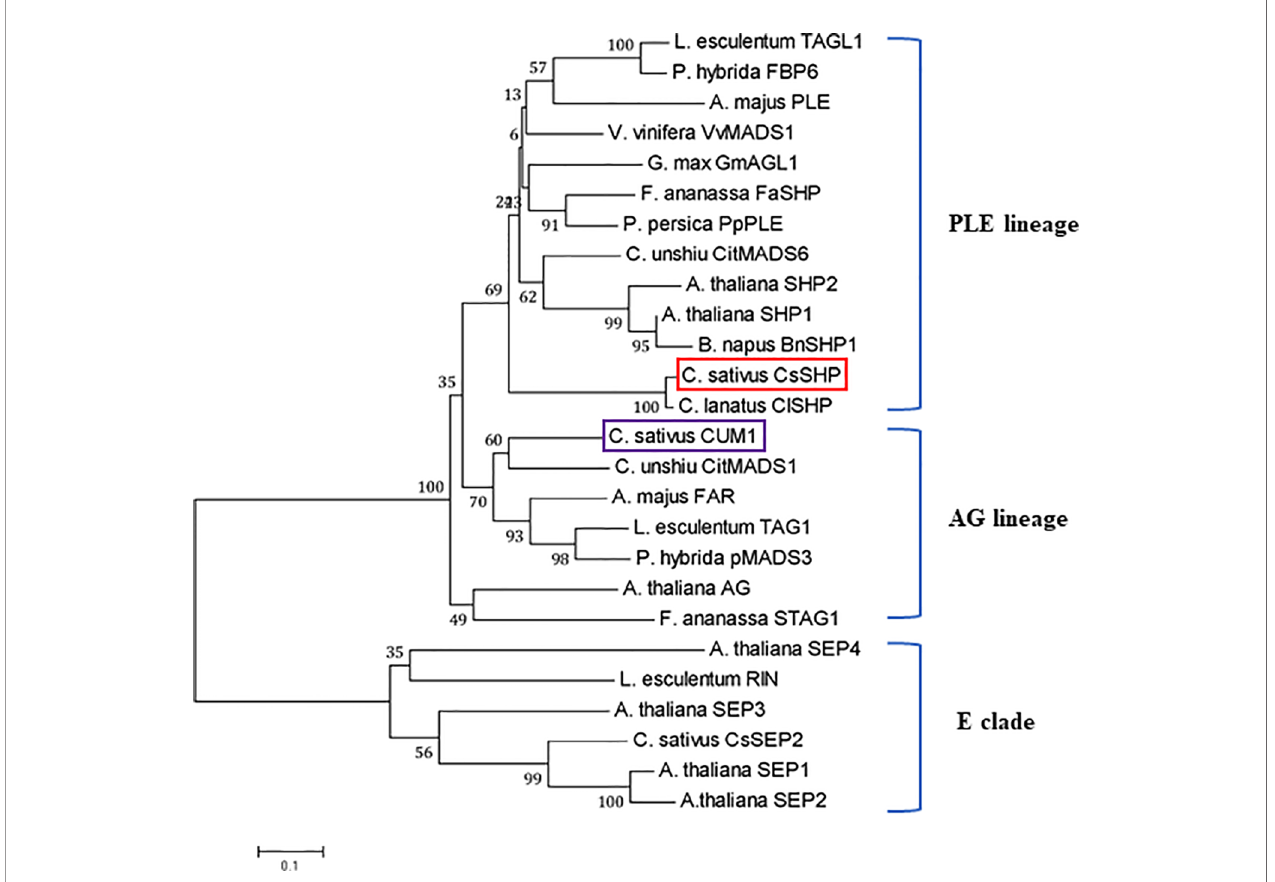
FIGURE 2 | Phylogenetic analysis of CsSHP and its homologous proteins. The scale bar represents 0.1 substitutions per site. The red and purple squares indicate CsSHP and CUM1, respectively. E lineage proteins were used as